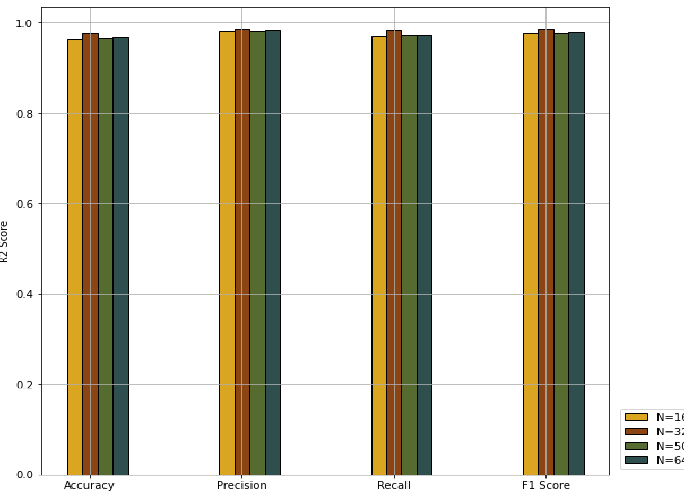
Figure 10. Performance comparison with different values for batch size.